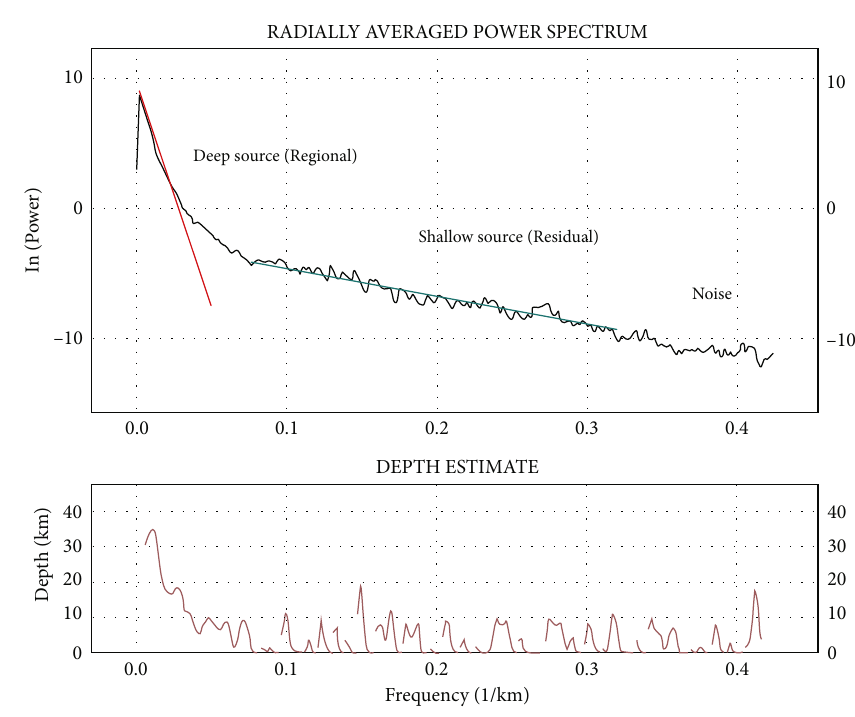
Figure 6: Local power spectrum of RTE magnetic data in the study